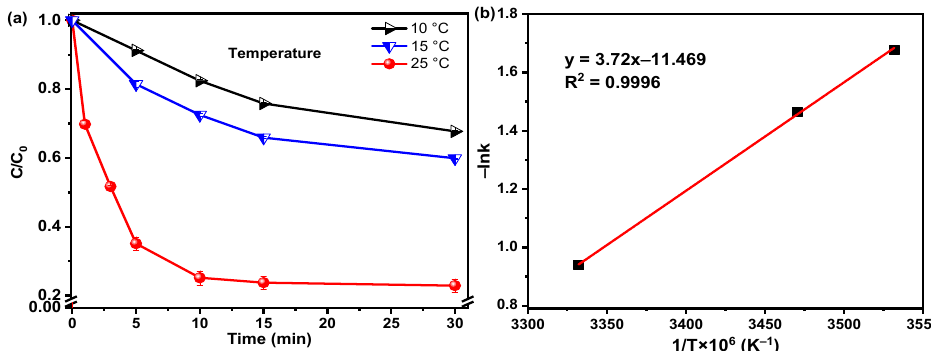
Figure 7. ( a ) Effect of the reaction temperature on the SMT removal and ( b ) the relation of 1/T and lnk in the Fenton-like reaction over the Fe-Mo/rGO catalyst. ([SMT] 0 = 0.076 mM, [Catalyst] = 0.2 g/L, [H 2 O 2 ] 0 = 20 mM, pH = 6.57).